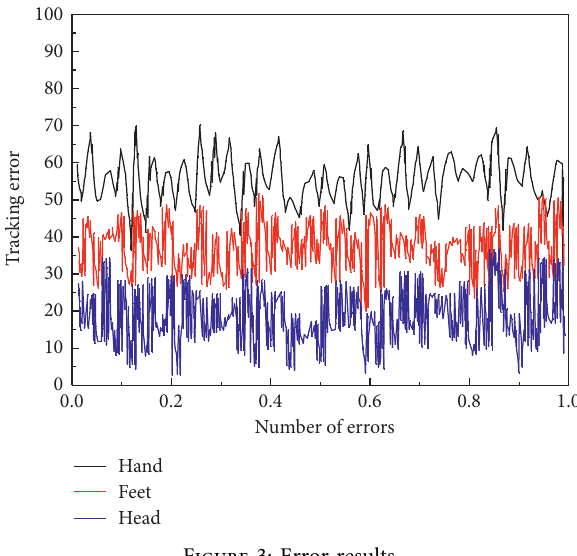
Figure 3: Error results.